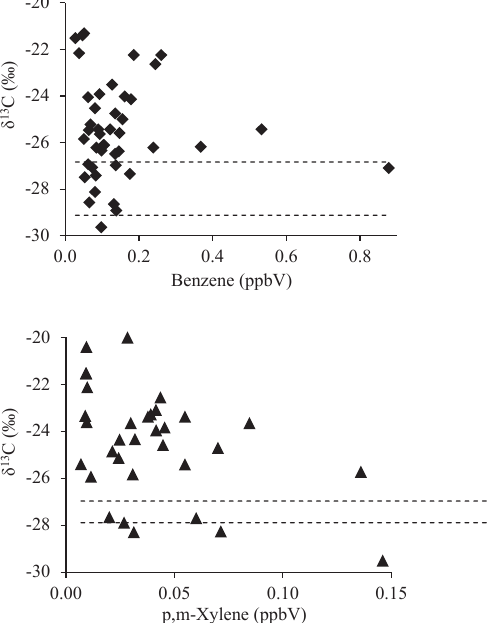
Figure 7. Mixing ratio versus stable carbon isotope ratio plots for samples collected at Egbert. The ranges (average ± σ) of isotope ratios reported by Rudolph et al. (2002) for urban sources are shown as dashed